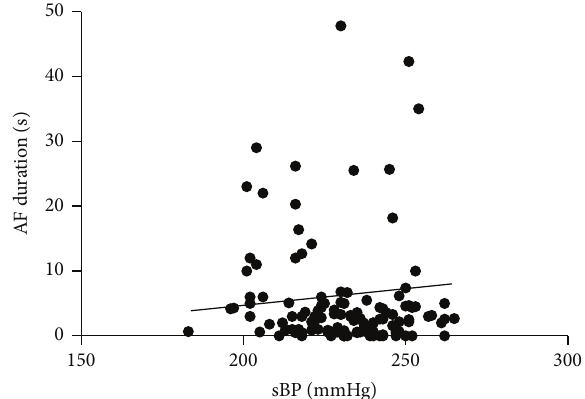
Figure 3: Relationship between the duration of atrial fibrillation (AF) with high (20 V) voltage stimulus and systolic blood pressure (SBP) in SHR.